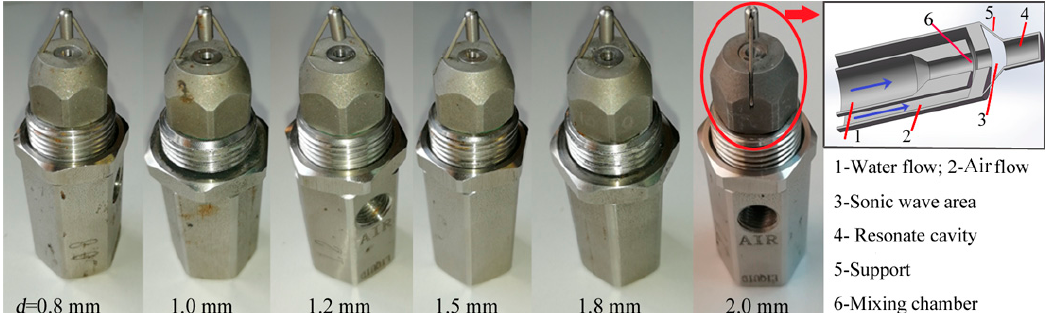
Figure 1. The ultrasonic atomizing nozzle s used in experiment.